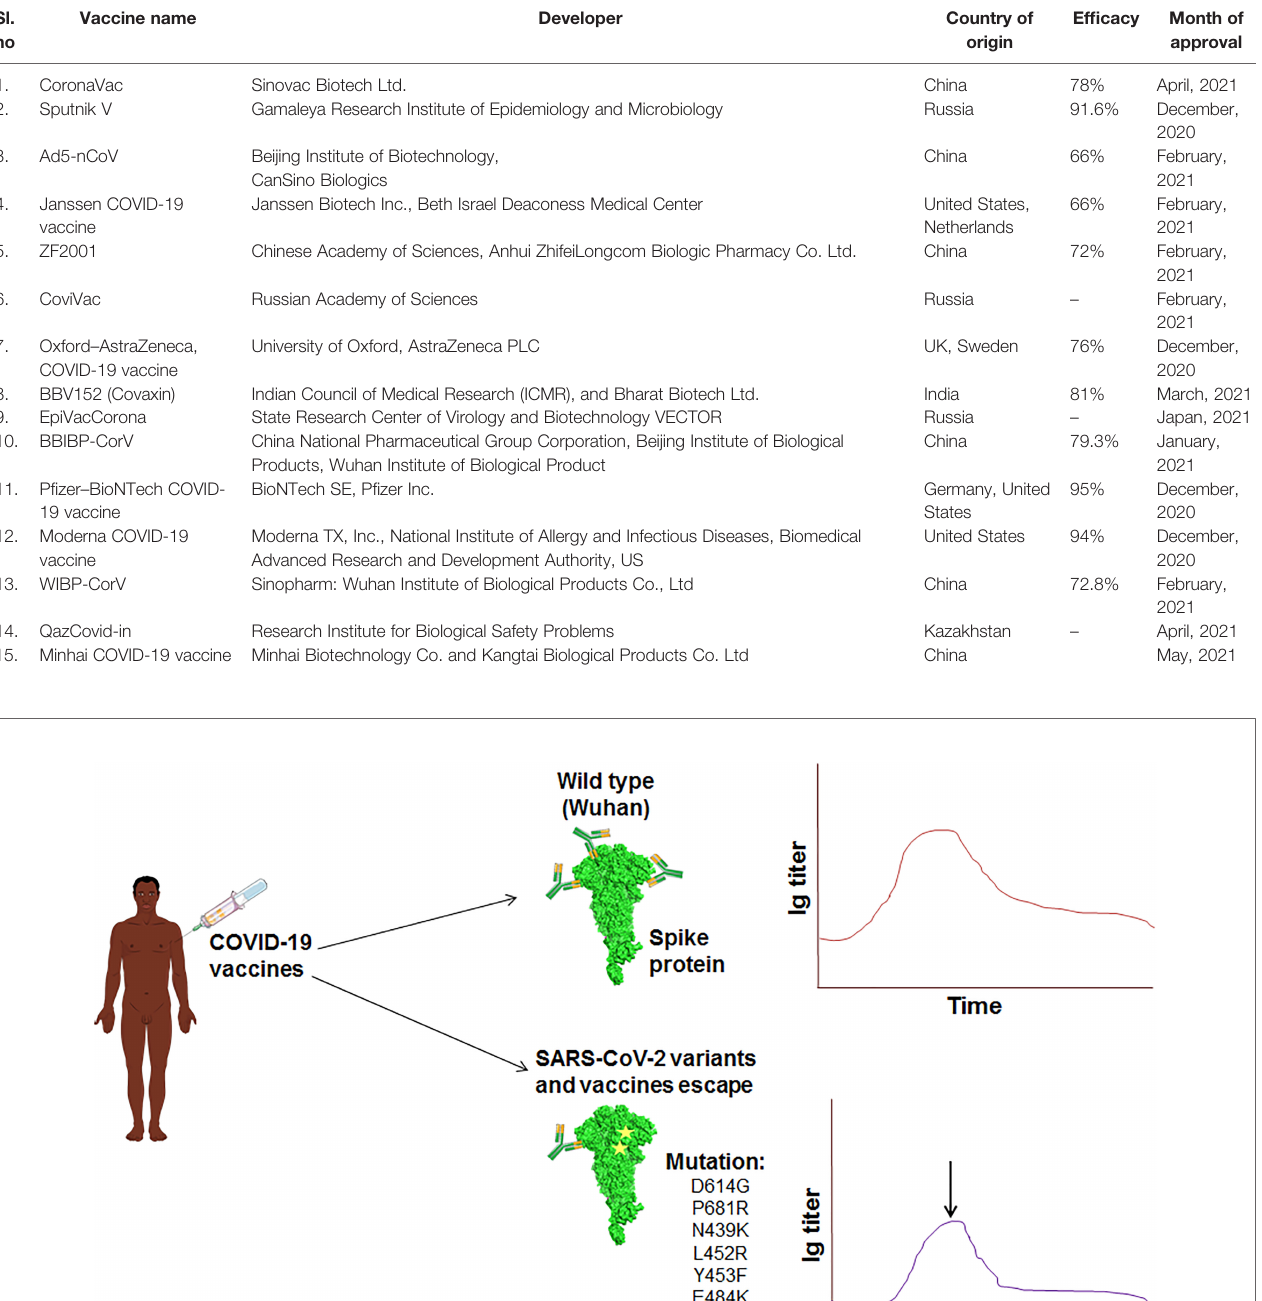
3.3foldreductionforthesevaccines)(236).Similarly,Zhouetal.found a reduction of ef fi cacy of Oxford-AstraZeneca vaccine against B.1.351 variant (about nine-fold reduction for this vaccine) (237).